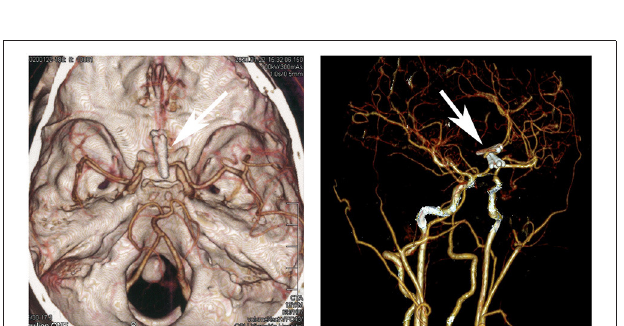
FIGURE 2 | Cerebral computed tomography angiography showing the ruptured anterior cerebral aneurysm (arrow).